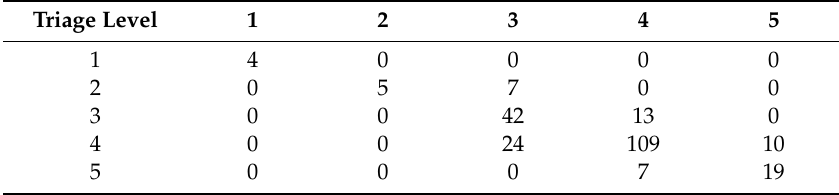
Table 5. Concordance in the classification of the level of triage between two nurses independently using the ESI triage system on 240 patients treated in the Emergency Service Department of the General Hospital of La Palma between February 2016 and February 2017. Triage Level